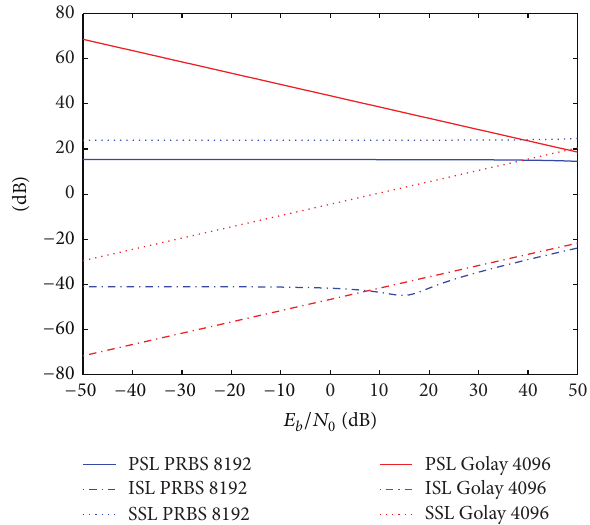
Figure 2: PSL, SSL, and ISL comparison for 4096-Golay and 8192- PRBS sequences with averaged